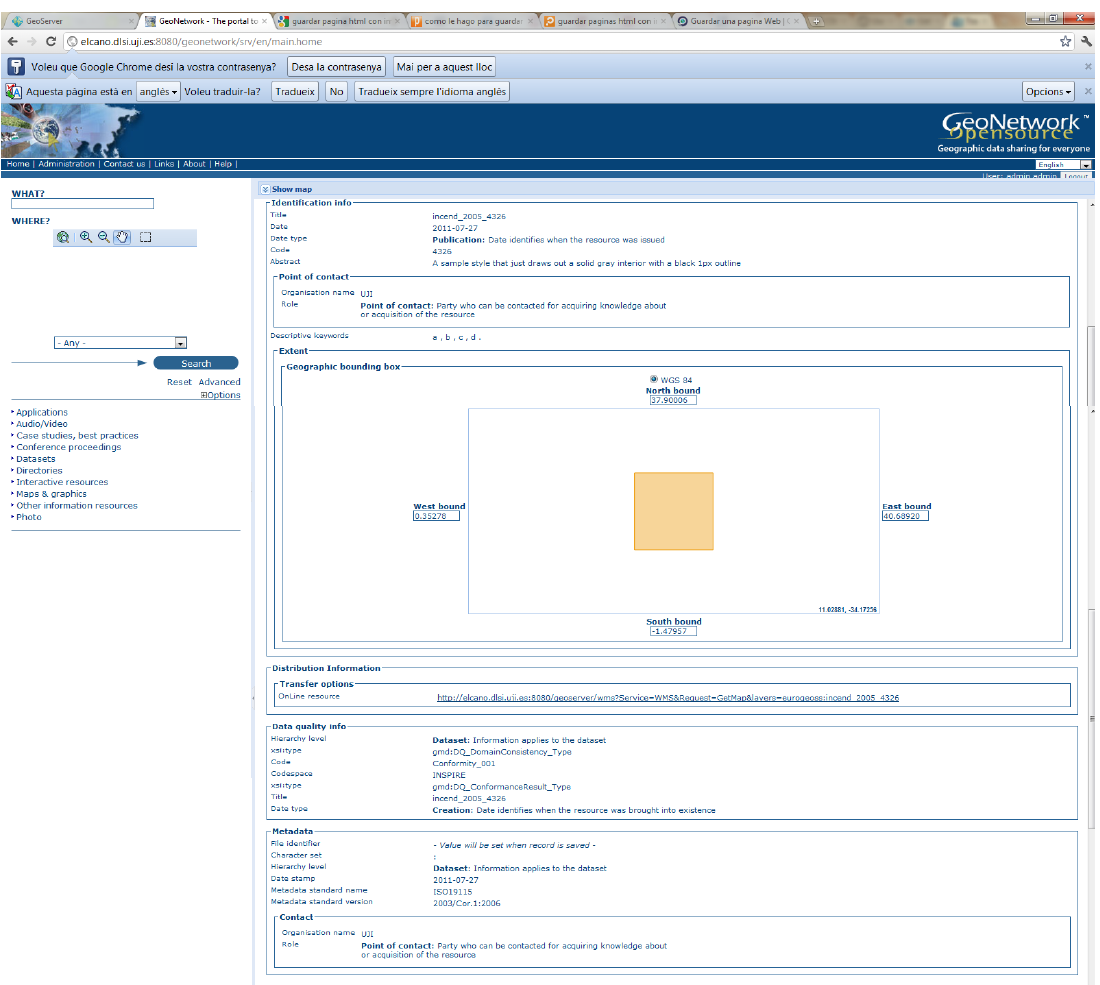
Figure 13. Screenshot of the data published in